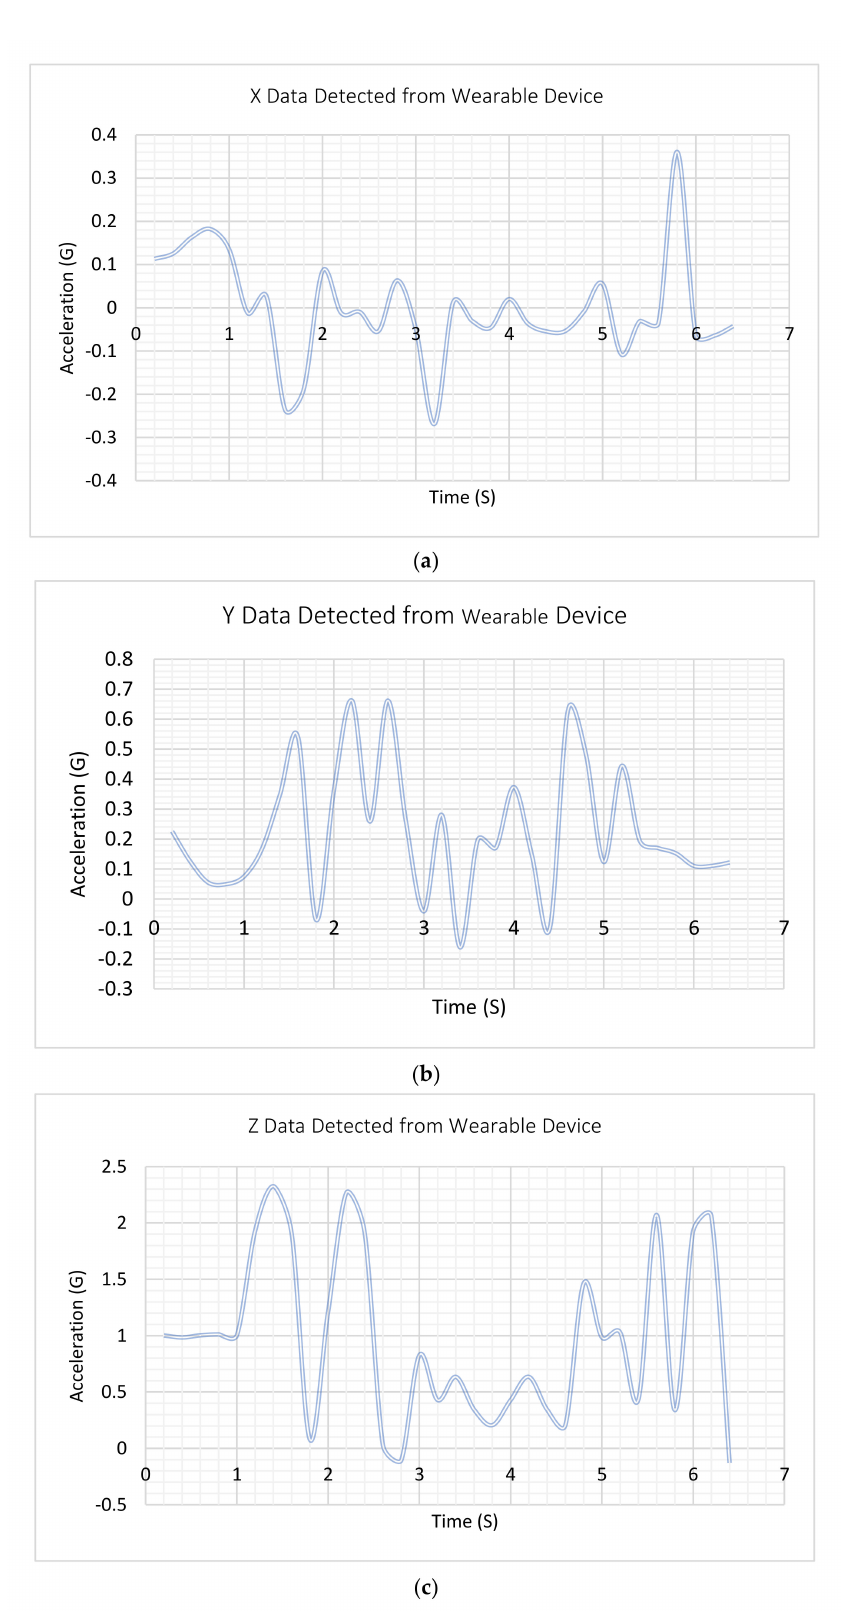
Figure 12. ( a ): X Data Detected from Wearable Device; ( b ): Y Data Detected from Wearable Device; ( c ): Z Data Detected from Wearable